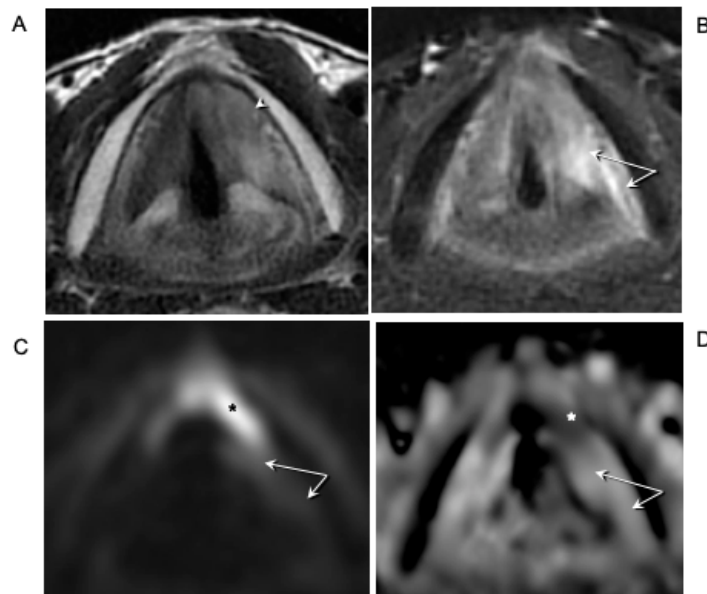
Figure 6. Left glottic radio-recurrent squamous carcinoma recently treated by OPHL type IIa + left Ary.